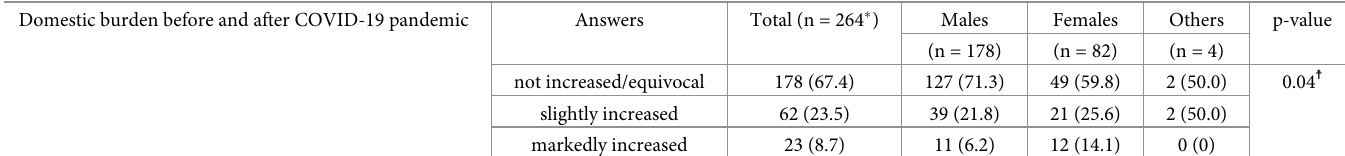
Table 2. The results of the questionnaire survey regarding changes of domestic burden due to the pandemic. Domestic burden before and after COVID-19 pandemic